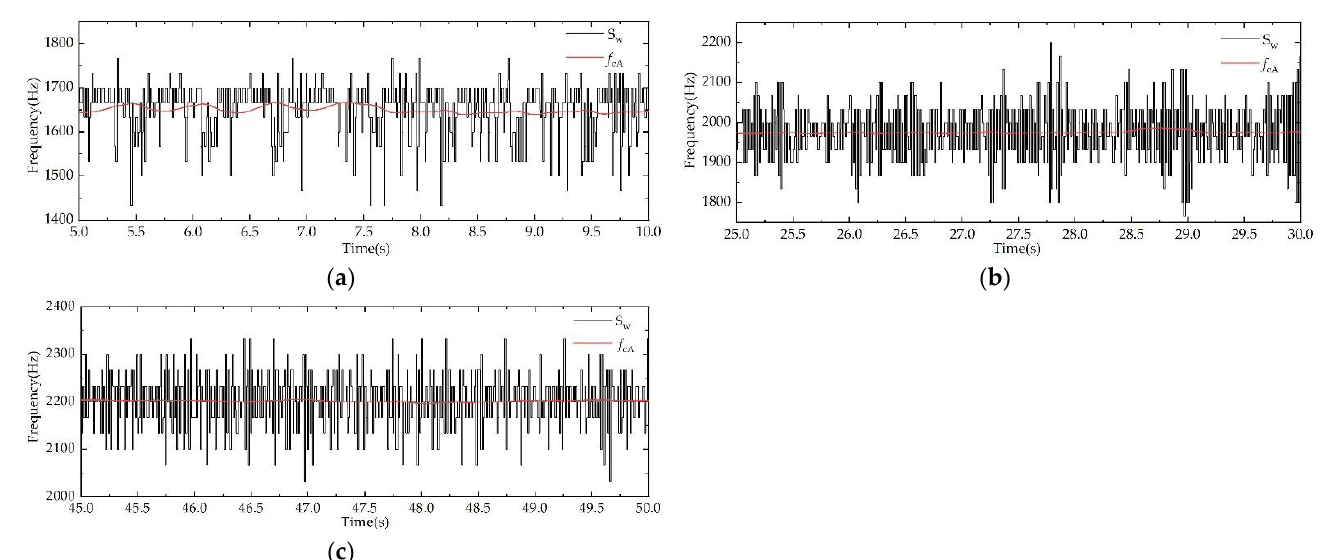
Figure 12. Speed up waveform: ( a ) Rotor position waveform; ( b ) Rotor position estimation error; ( c ) Rotor position local enlarged waveform at t = 20 s; ( d ) Rotor position local enlarged waveform at t = 35 s.